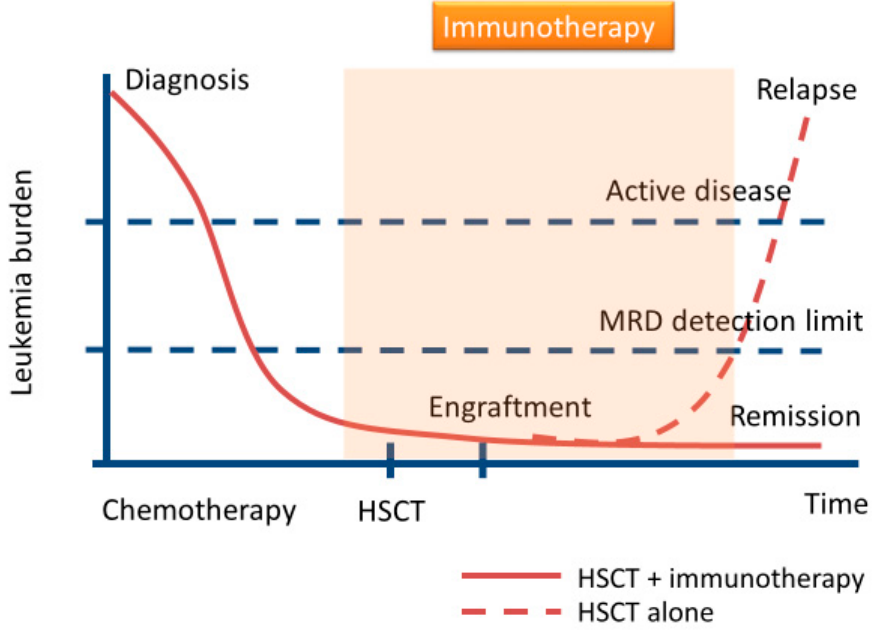
Figure 1. Schematic diagram of immunotherapies for minimal residual disease (MRD) eradication after allogeneic hematopoietic stem cell transplantation (allo-HSCT) in acute myeloid leukemia (AML). Some patients with AML after conventional allo-HSCT will relapse. For the prevention of relapse, immunotherapies may play an important role in the elimination of MRD.